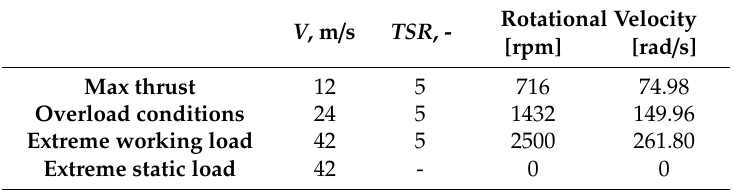
Table 3. Load cases under inspection in structural analysis.